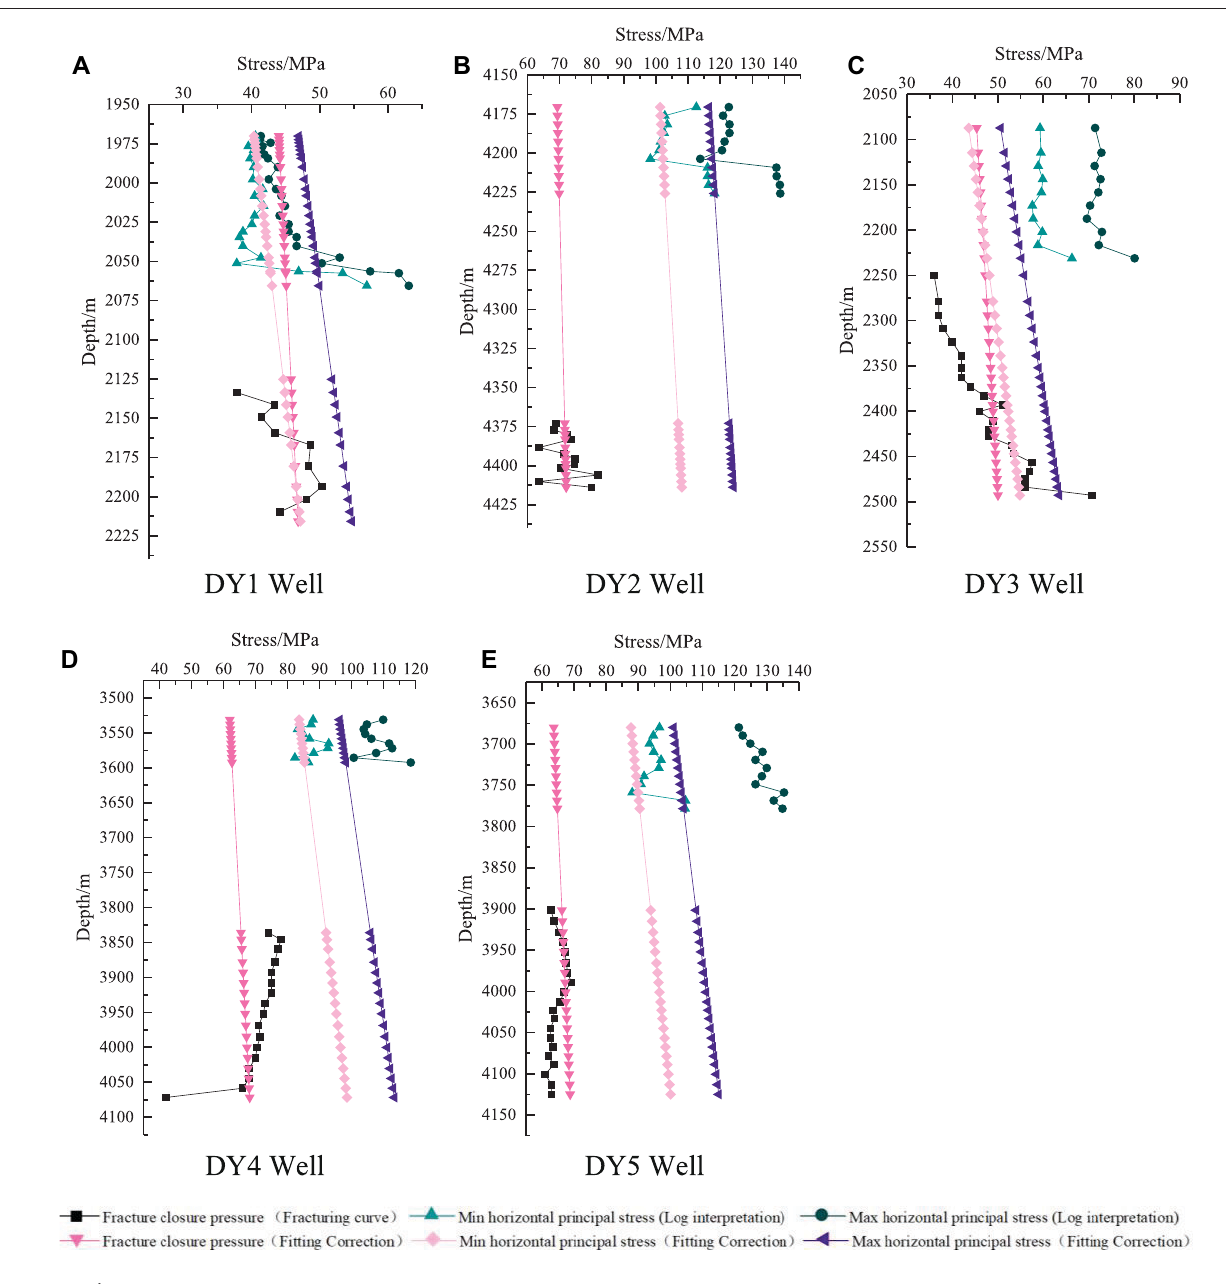
Frontiers in Earth Science |